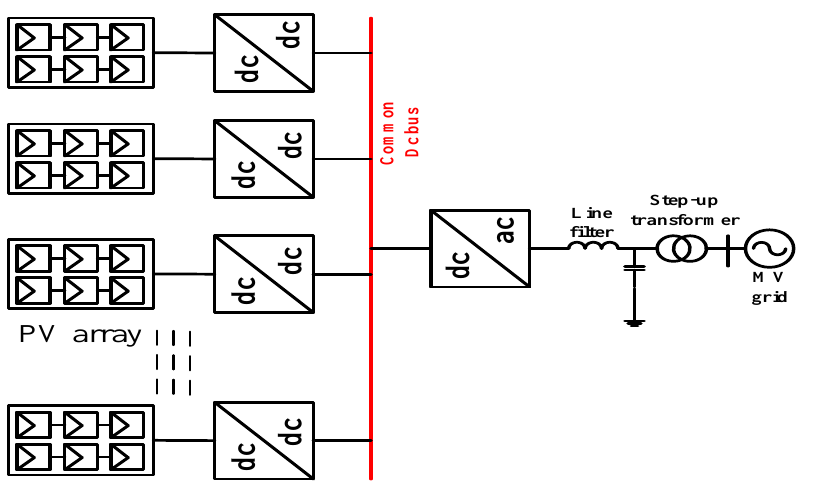
Figure 1. Topology of solar PV grid-connected system [10].